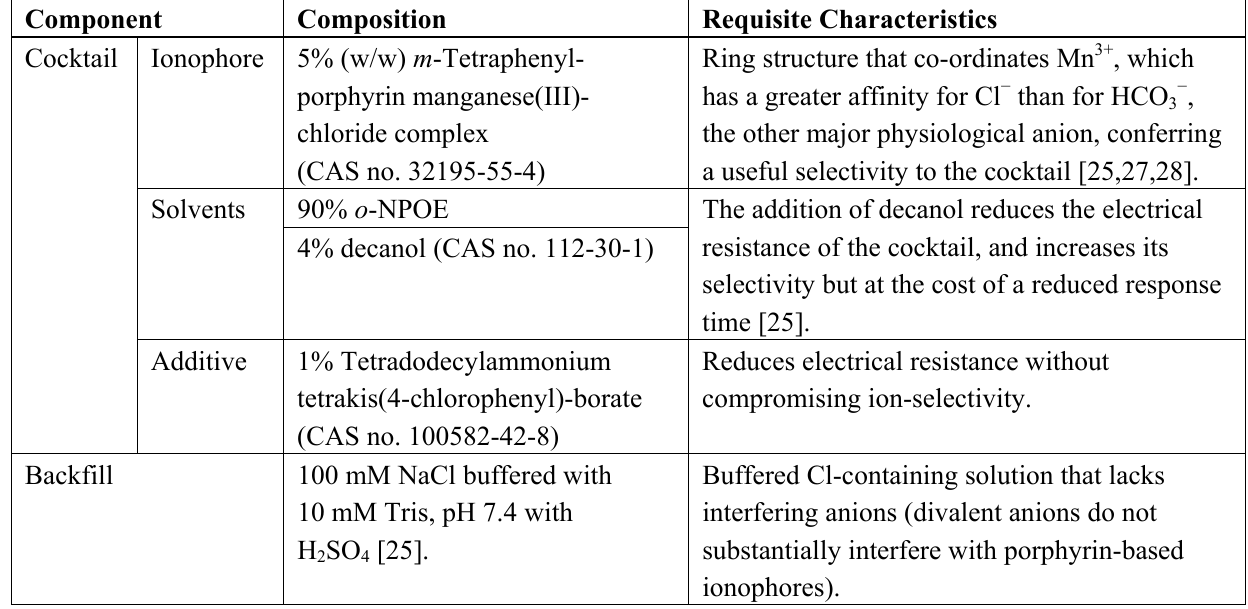
Table 4. The composition and components of Cl − -selective ionophore I cocktail A (Sigma cat. no. 99408). Further details are provided at The Sensor Application Portal hosted at